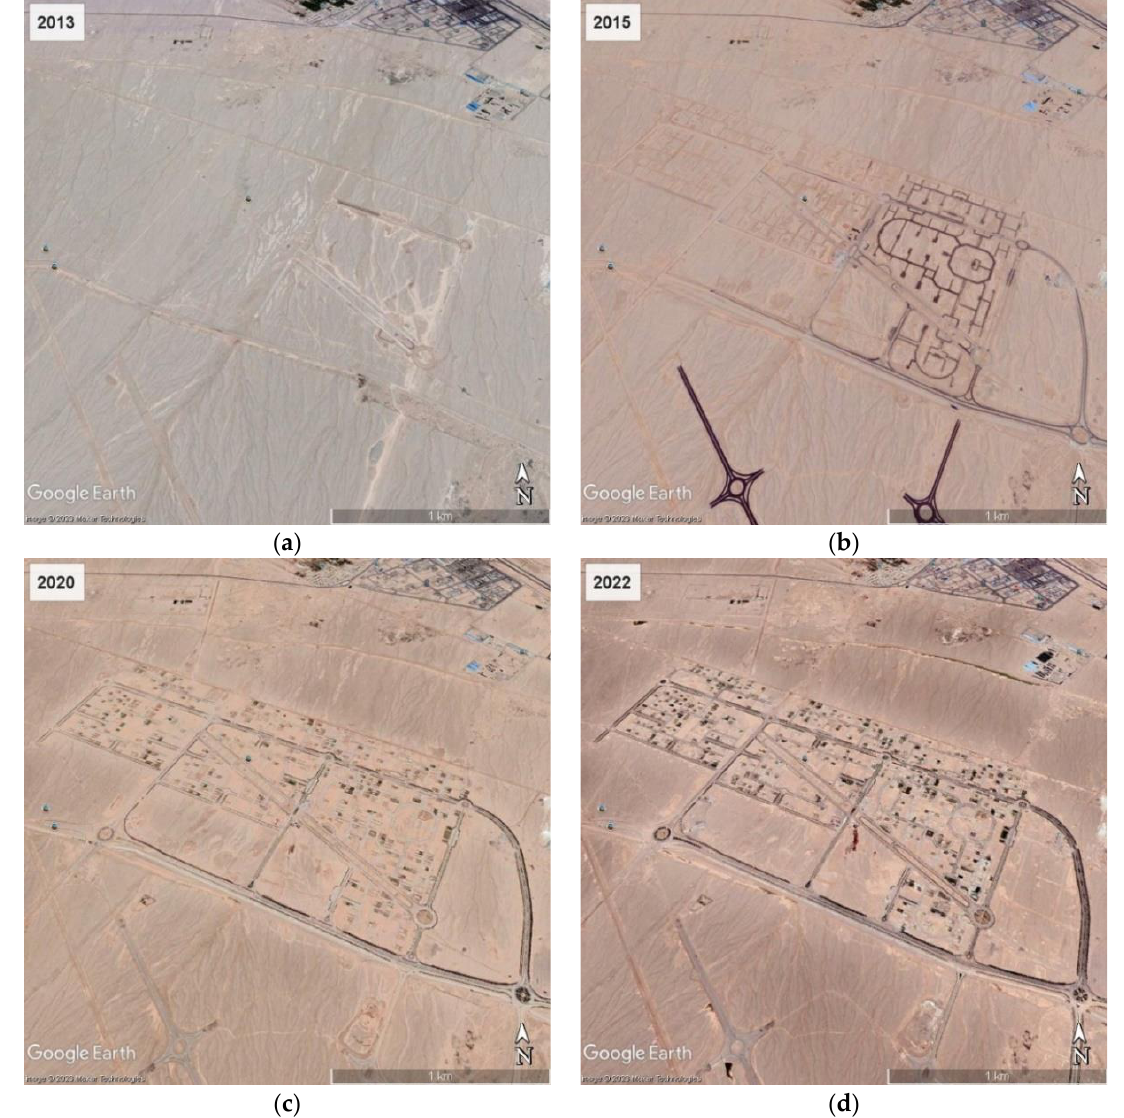
Figure 3. Google Earth images of Karizland town in 2013 ( a ), 2015 ( b ), 2020 ( c ), and 2022 ( d ), which show the stages of establishing the town.